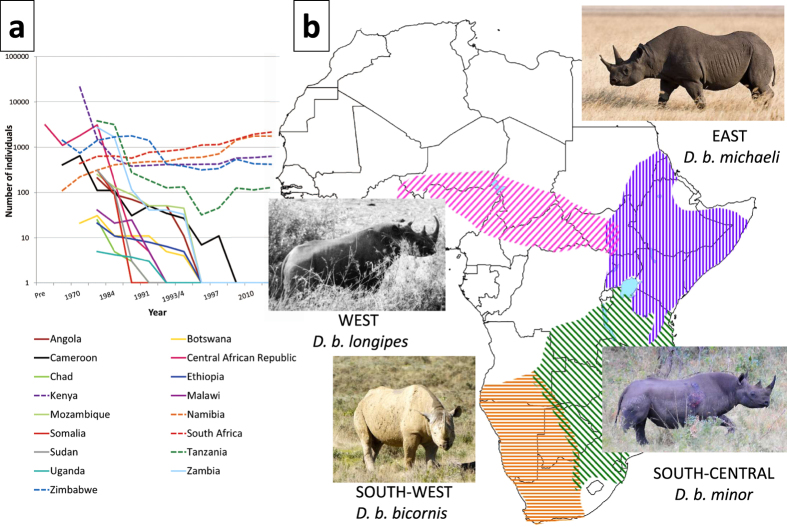
Decrease in black rhinoceros numbers and the distribution of the species across sub-Saharan Africa.(a) Decreases in black rhinoceros numbers across Africa in the latter half of the 20th century. Dashed lines indicate extant aboriginal populations. Data from the African Rhino Specialist Group (AfRSG) and (b) Range-wide distribution of the black rhinoceros in sub-Saharan Africa. Subspecies mapped are according to du Toit (1987)11 and this is the status quo for conservation management by the AfRSG. This map was created using the following R packages: geoR67, raster68, rgdal69 and maptools70.